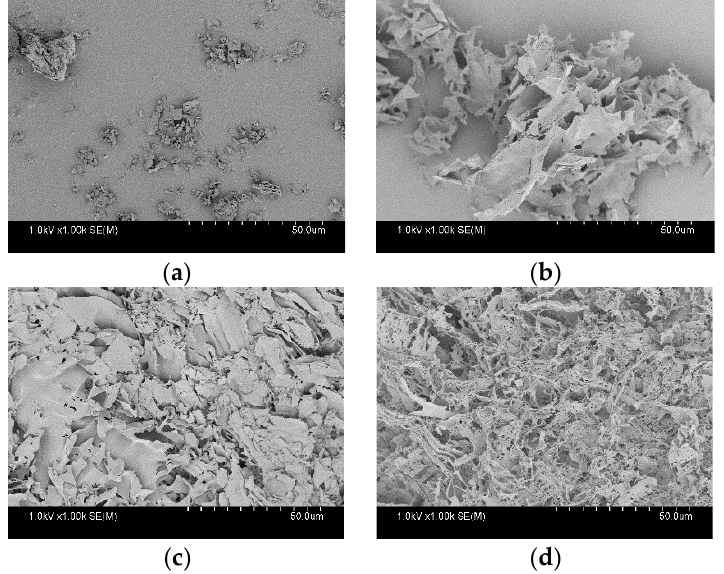
Figure 3. SEM images of ( a ) crystalline ALZ, ( b ) HPMCAS ASD, ( c ) Eudragit ASD, and ( d ) PVPVA ASD.